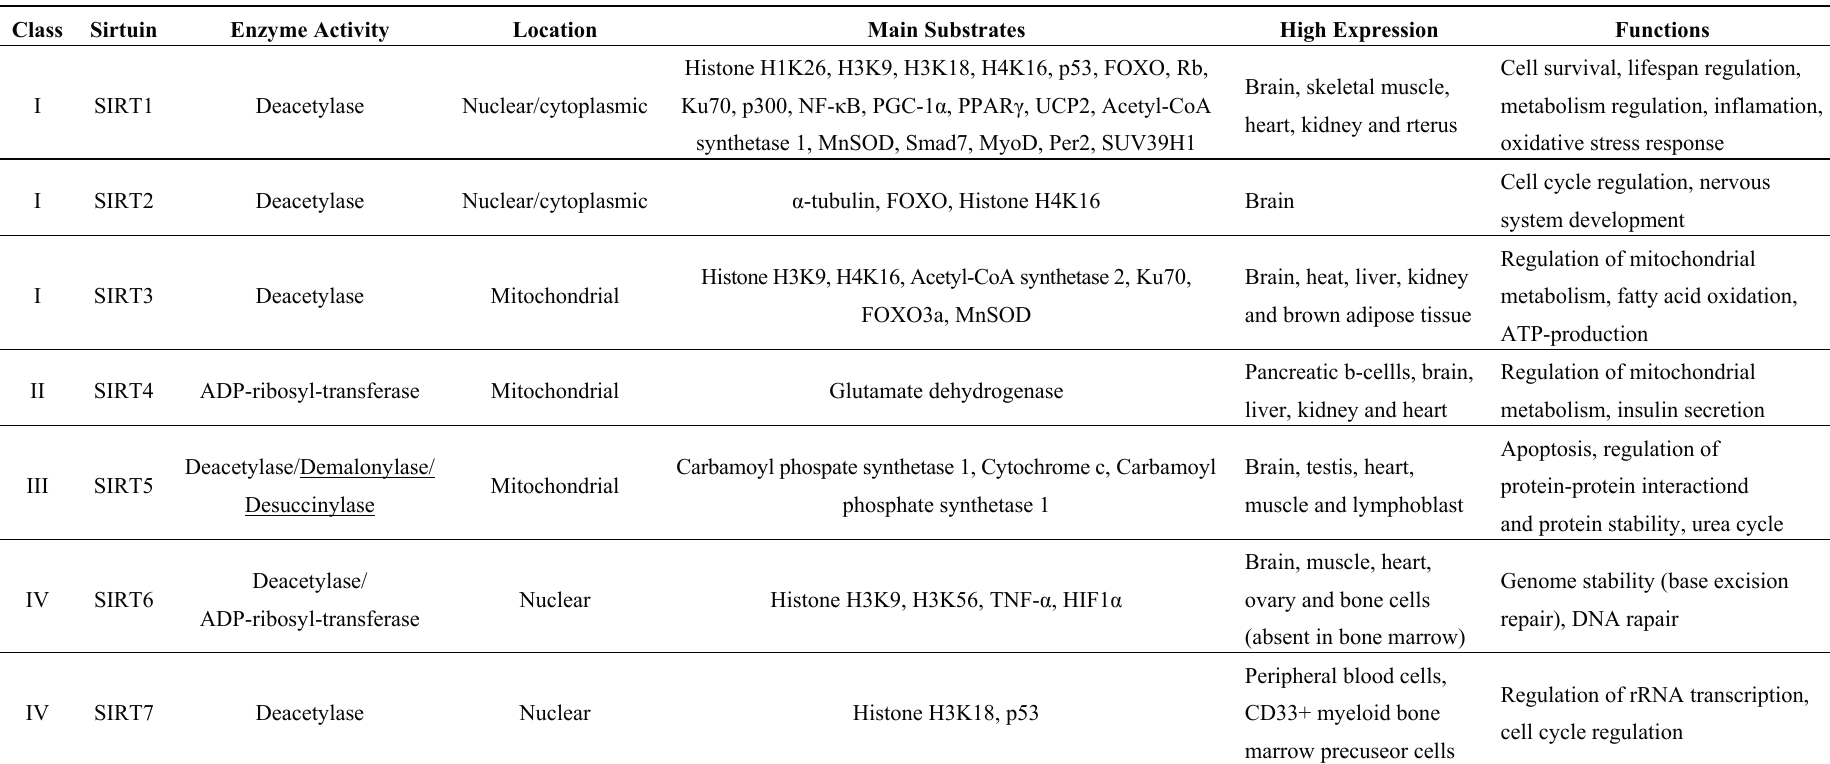
Table 1. Diversity of